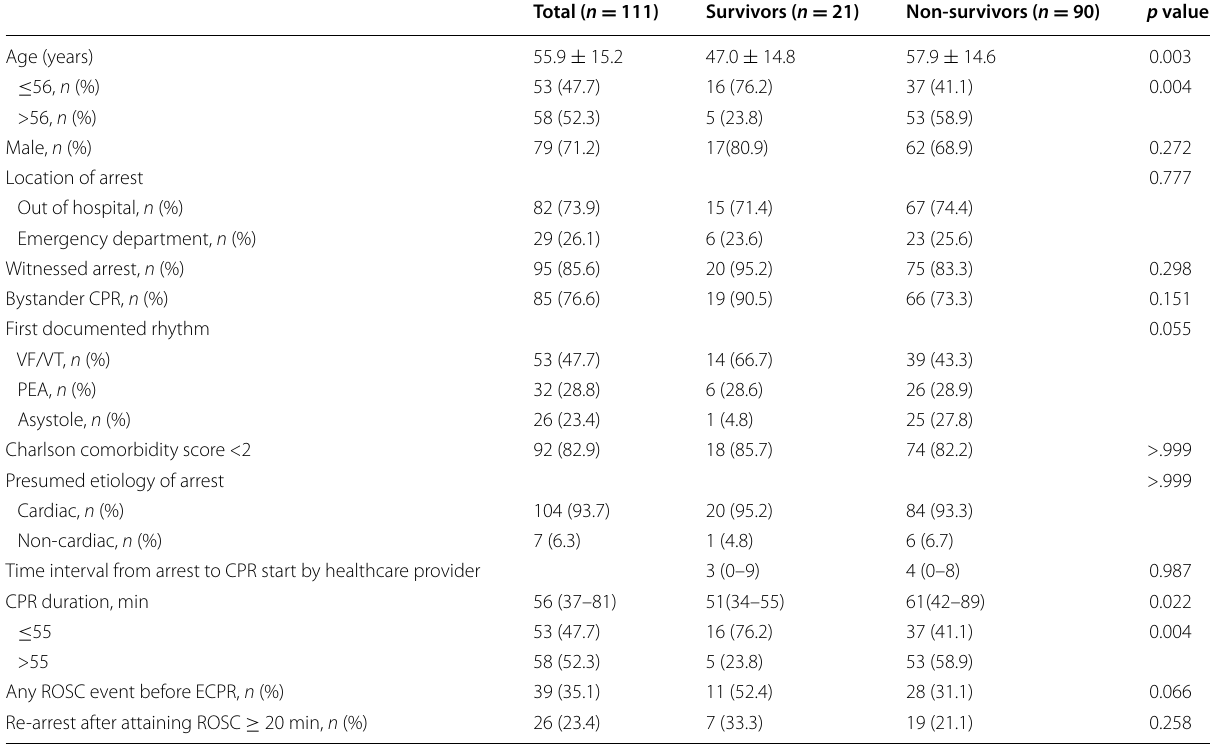
Table 1 Patient characteristics and cardiopulmonary resuscitation-related